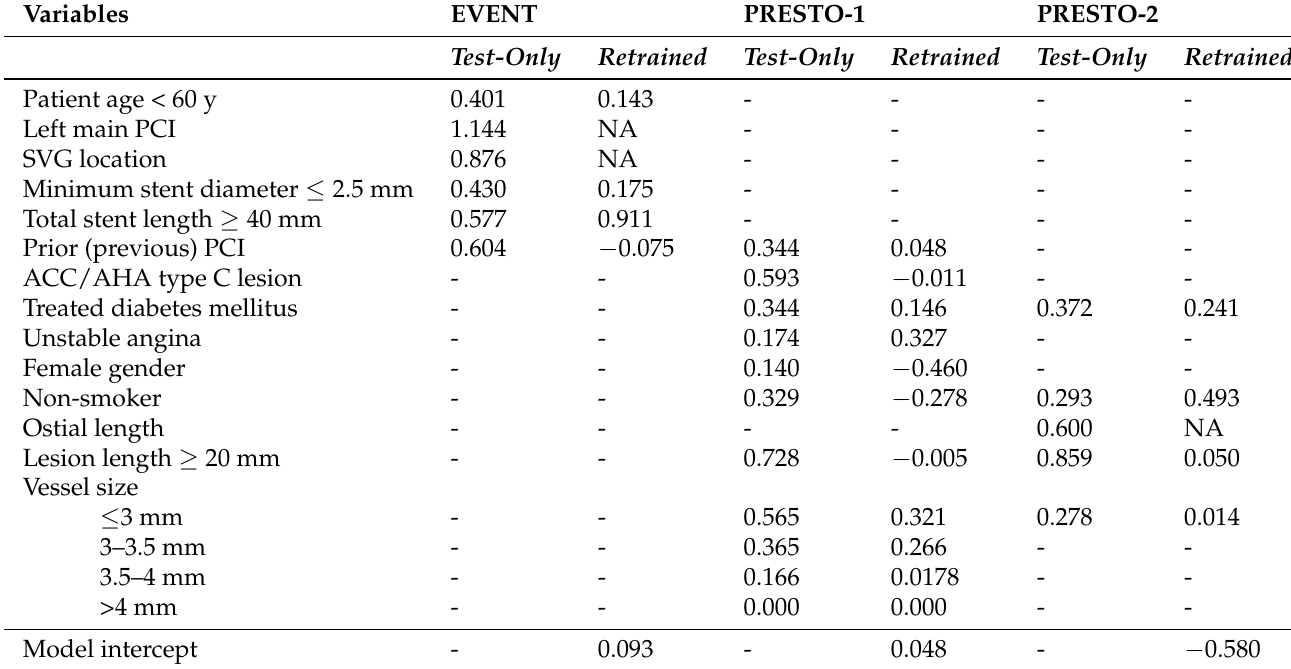
Table 5. The model parameter values ( β -coefficients for logistic regression-based models) as were reported in the literature by authors ( test-only columns), and after retraining on our database ( retrained columns); PRESTO-1 [20], PRESTO-2 [11], EVENT [21]. The outcome of interest here is TLR, similar to the original studies. The last row indicates the logistic regression model intercept, only reported for retrained models, and not reported by the authors. NA means the parameter did not exist in our database; - means the parameter did not exist in the original